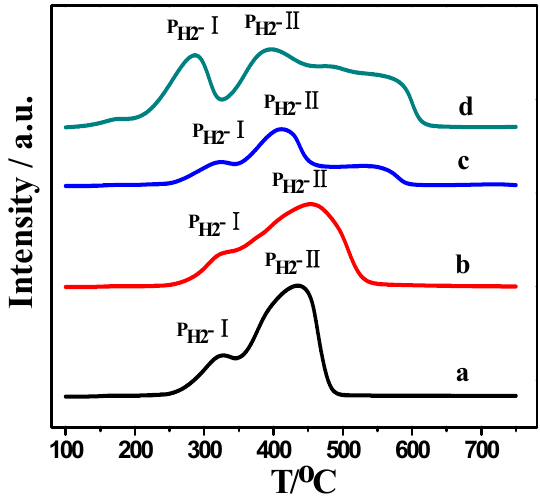
Figure 2. Hydrogen temperature ‐ programmed reduction (H 2 ‐ TPR) profiles of Mg x Ce y Co 1 − x − y Co 2 O 4 composite Mg 0.025 Ce 0.05 Co 0.925 Co 2 O 4 . PH 2 ‐ I: H 2 reduction of Co 3 O 4 to CoO; PH 2 ‐ II: H 2 reduction of CoO to Co 0